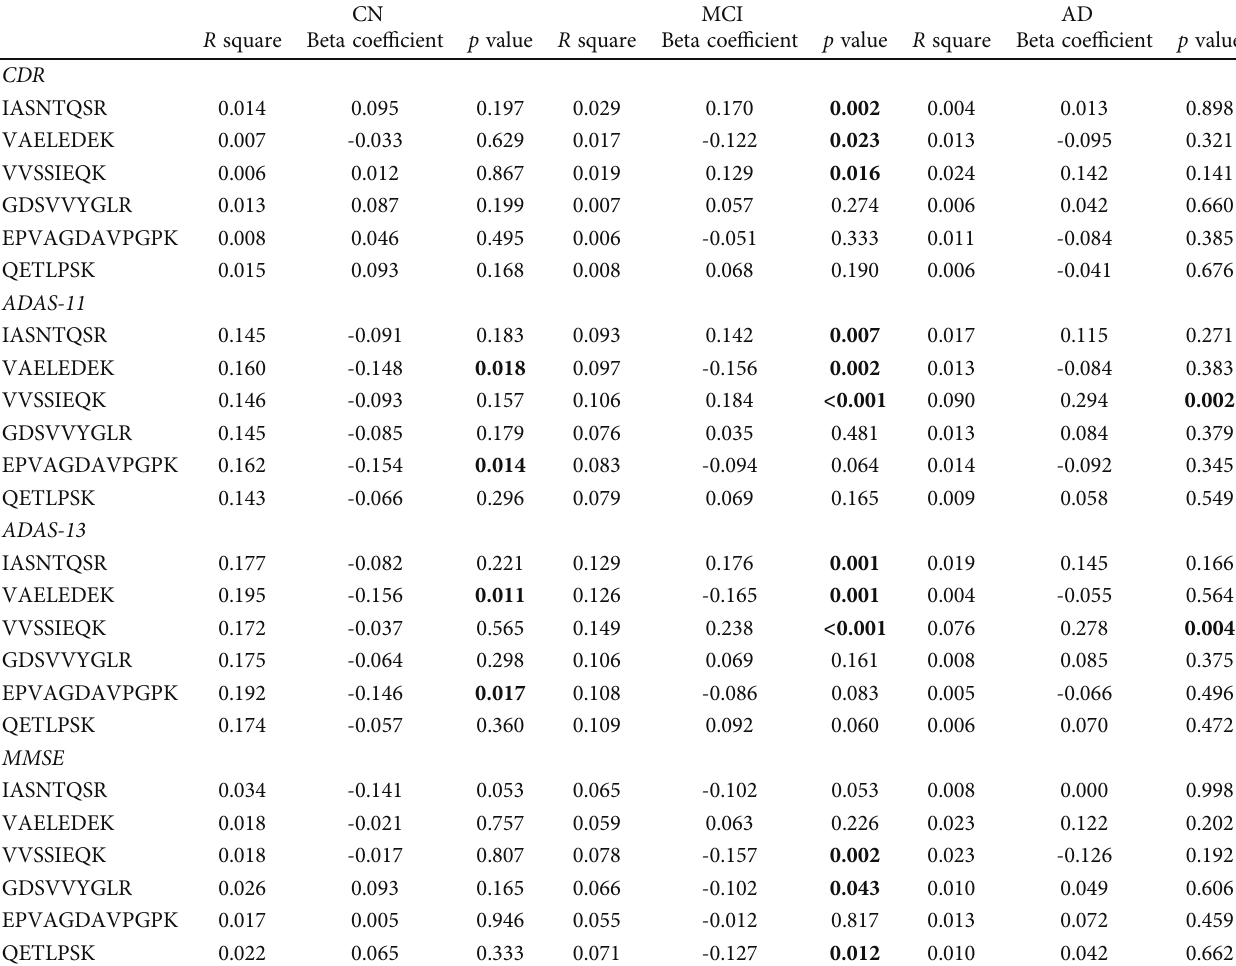
Table 4: Linear regression between cognitive assessments and targeted